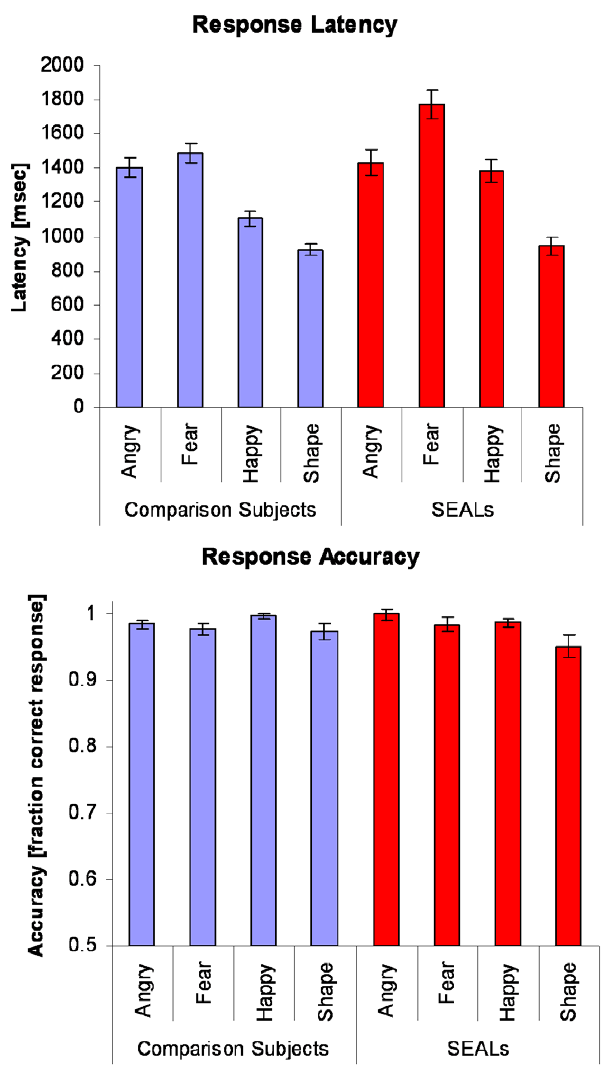
showed no differences on accuracy but subtle response latency differences across groups (see text for